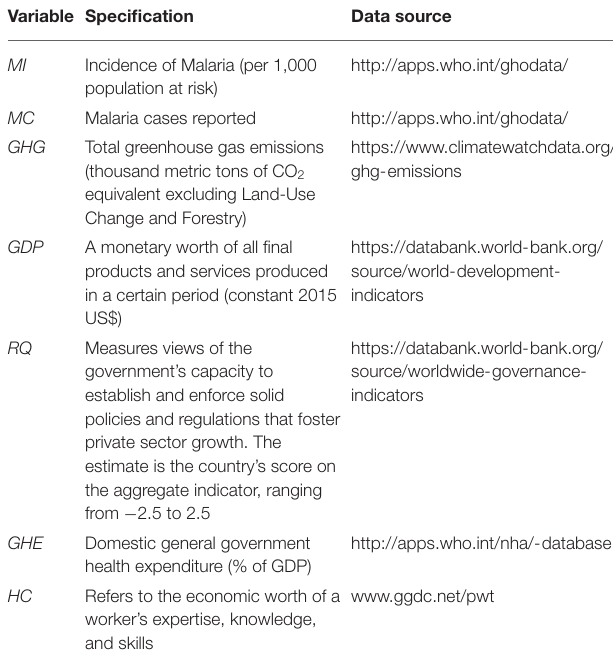
TABLE 1 | Variables specification and data